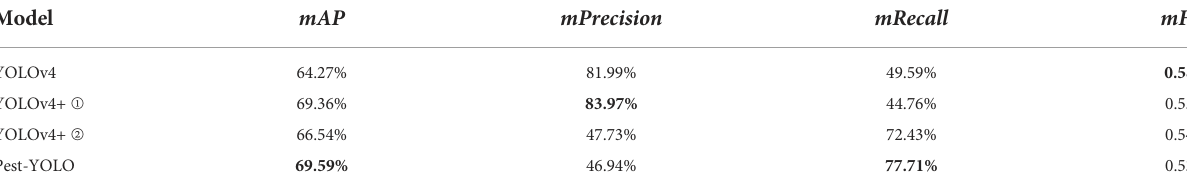
TABLE 3 Results of the ablation